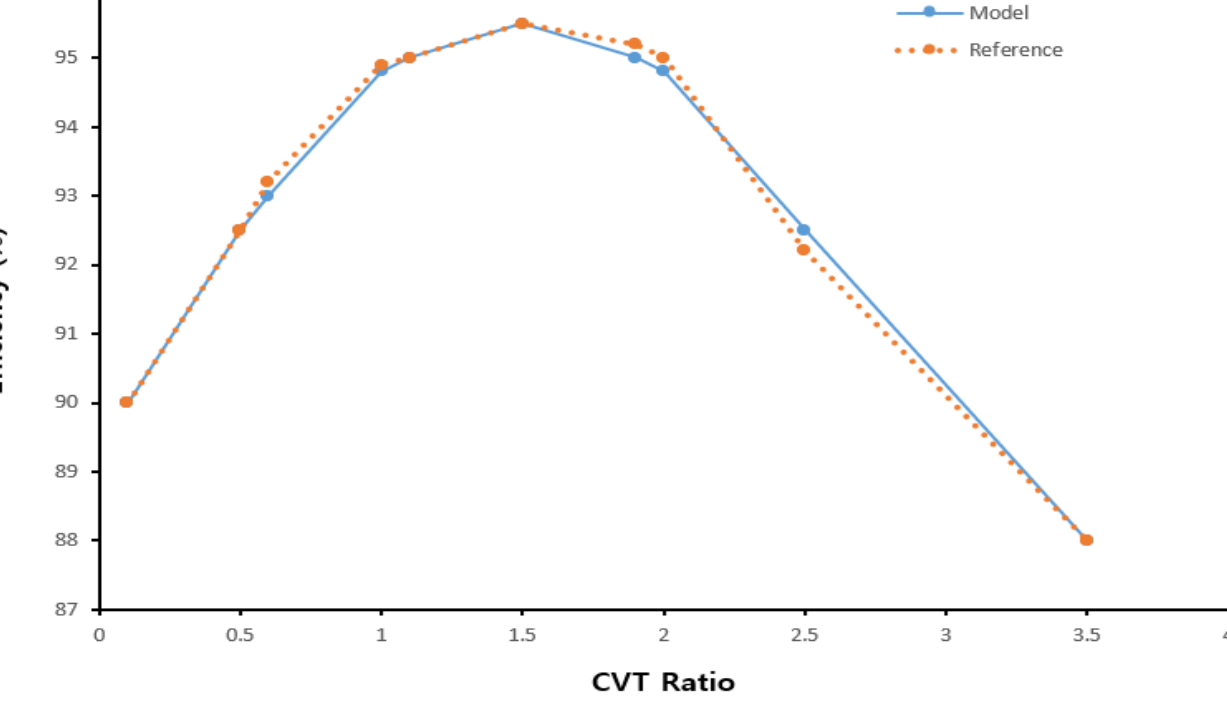
Figure 7. Efficiency of CVT according to shift ratio.